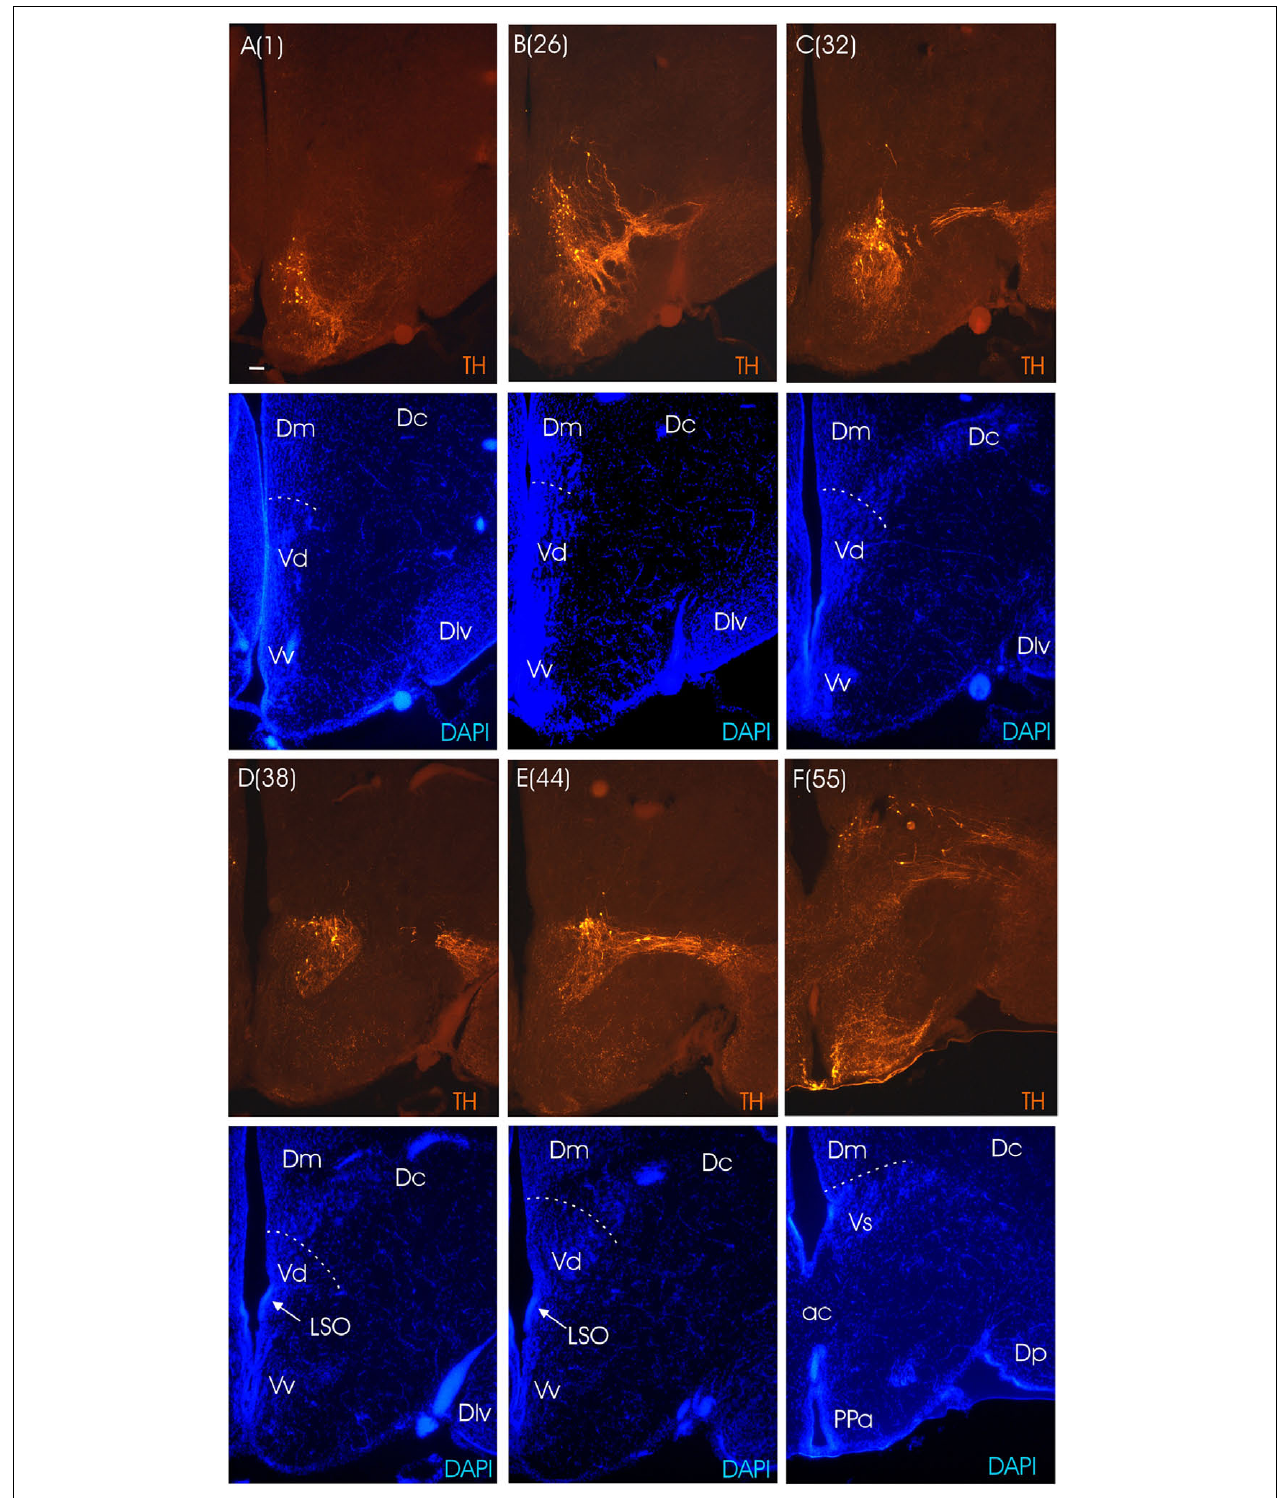
FIGURE 4 | Consecutive transverse sections of the archerfish telencephalon ranging from anterior to posterior (A–F). Sections are immunostained for tyrosine hydroxylase (TH) with accompanying nuclear (DAPI) counterstain. Stippled lines indicate pallial-subpallial boundary. Note that all dopaminergic cell bodies are within the subpallium. Arabic numerals in brackets indicate the relative distance of sections. Scale bar in (A) : 0.1 mm (applies to all panels). See abbreviation list and text for details.